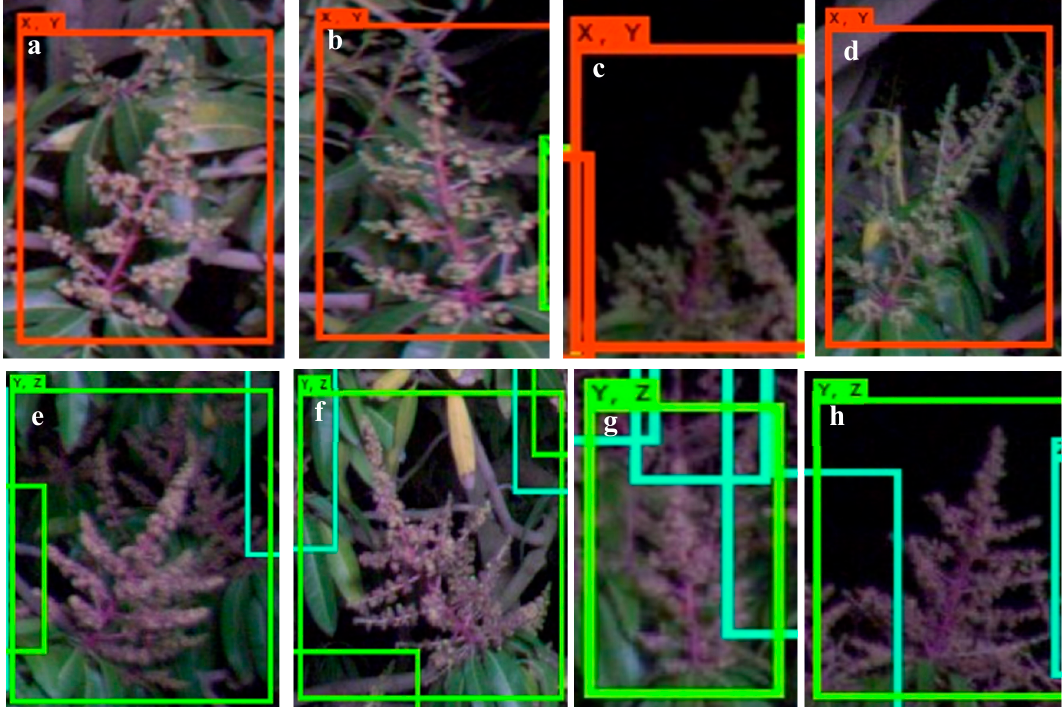
Figure 8. Ambiguity in classification. Examples of the panicle stages which the YOLO models predicted to 50% probability for each class. The top ( a – d ) and bottom ( e – h ) panels depict panicles classified to both classes X and Y (a,b,e,f), and Y and Z (c,d,g,h), respectively.